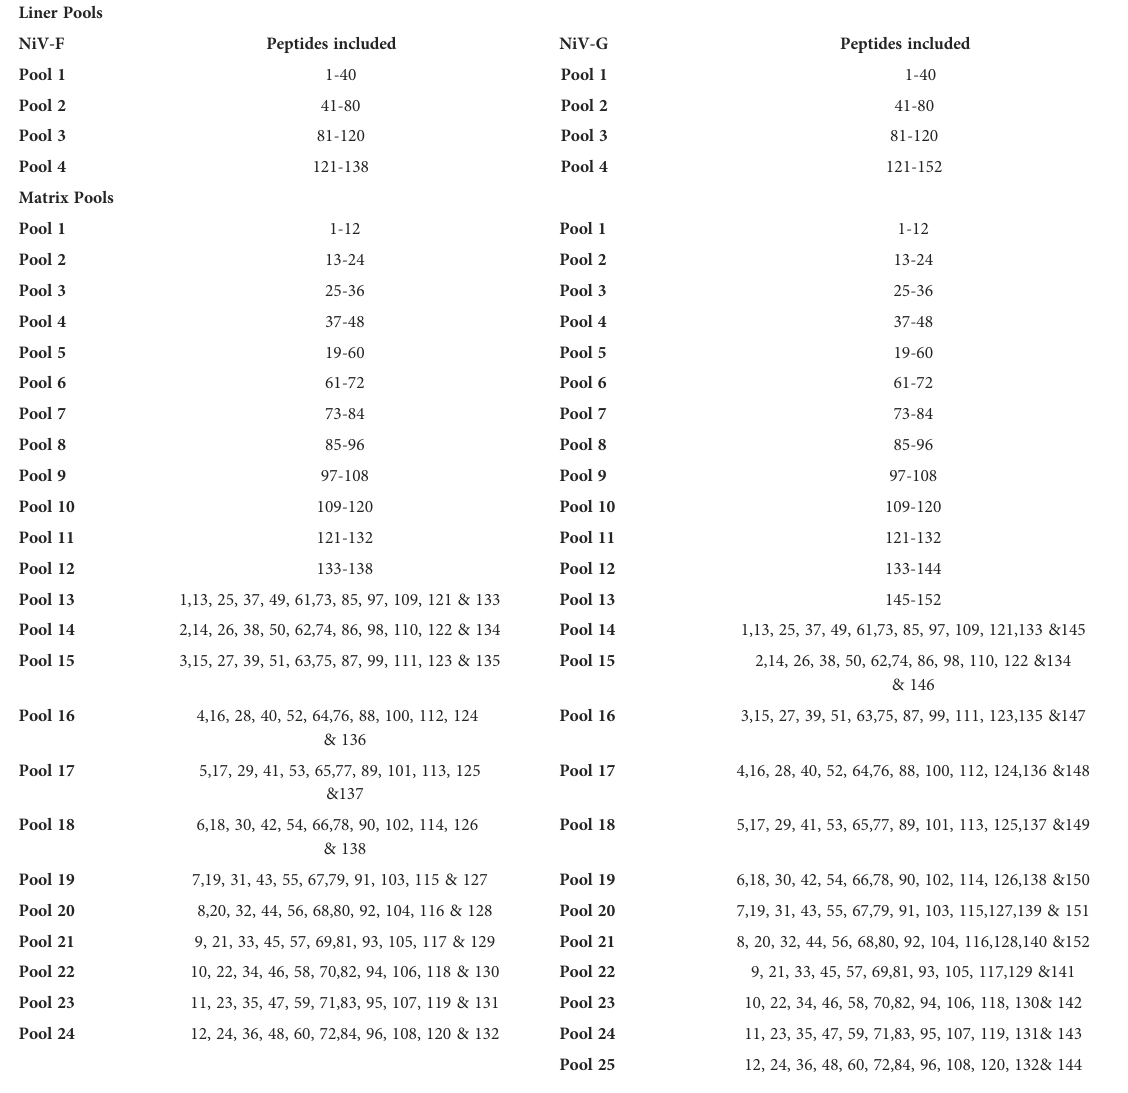
TABLE 1 The corresponding list of NiV-F/G liner and Matrix peptide